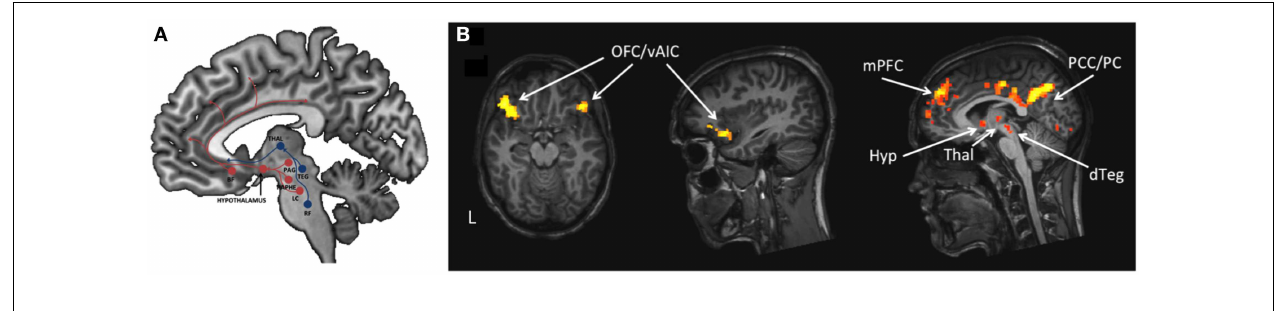
FIGURE 2 |The ascending arousal system involved in regulation of sleep and wakefulness . (A) The figure is a schematic description of the ventral (red) and dorsal (blue) pathways of the ascending arousal system. BF = basal forebrain,Thal = thalamus, PAG = periaqueductal gray, Raphe = Raphe nuclei, LC = locus coeruleus, TEG = tegmentum, RF = reticular formation. (B) .The figure shows